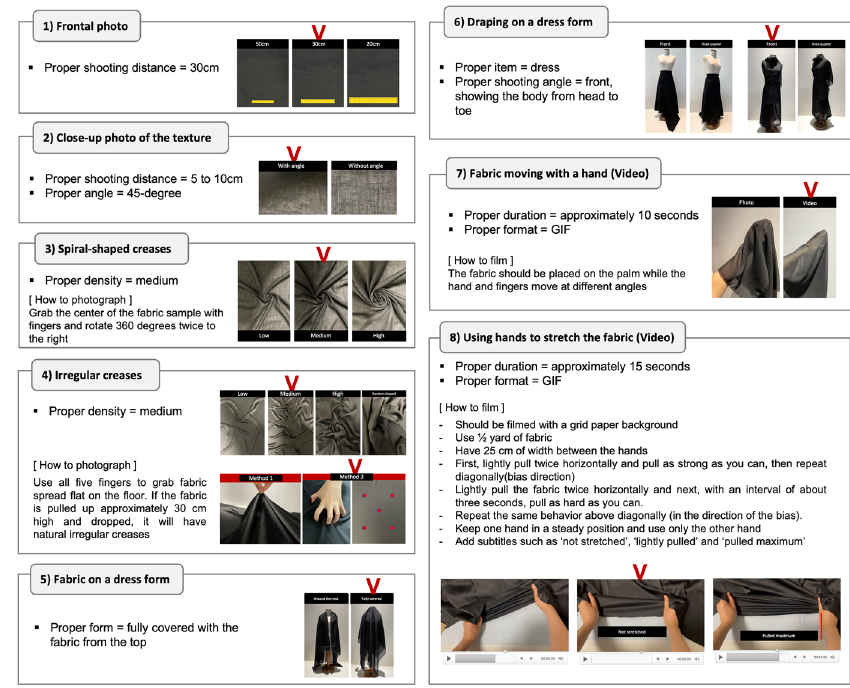
Fig. 3 Refinement of the visual presentation method and guidelines for